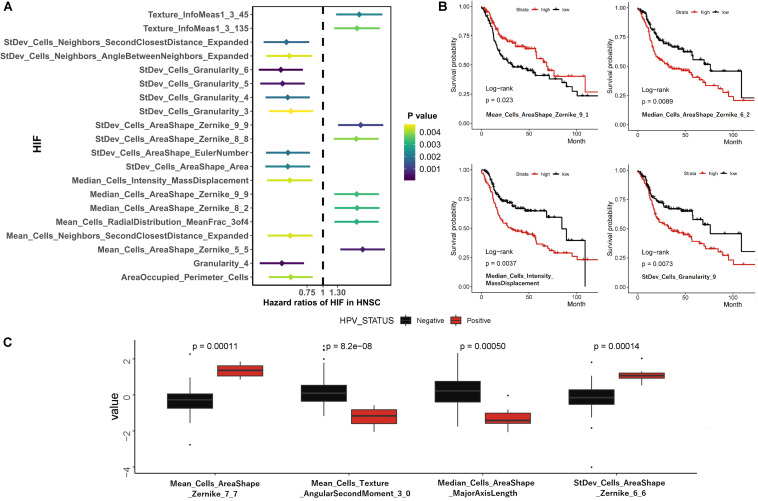
Univariate survival prediction using histopathological image features. (A) Survival difference between groups separated by median values of image feature in Cox regression analyses. (B) Kaplan-Meier curves for “Mean_Cells_AreaShape_Zernike_9_1,” “Median_Cells_AreaShape_Zernike_6_2,” “Median_Cells_Intensity_MassDisplacement,” and “StDev_Cells_Granularity_9.” (C) The different distribution of image features between HPV- and HPV + patients.